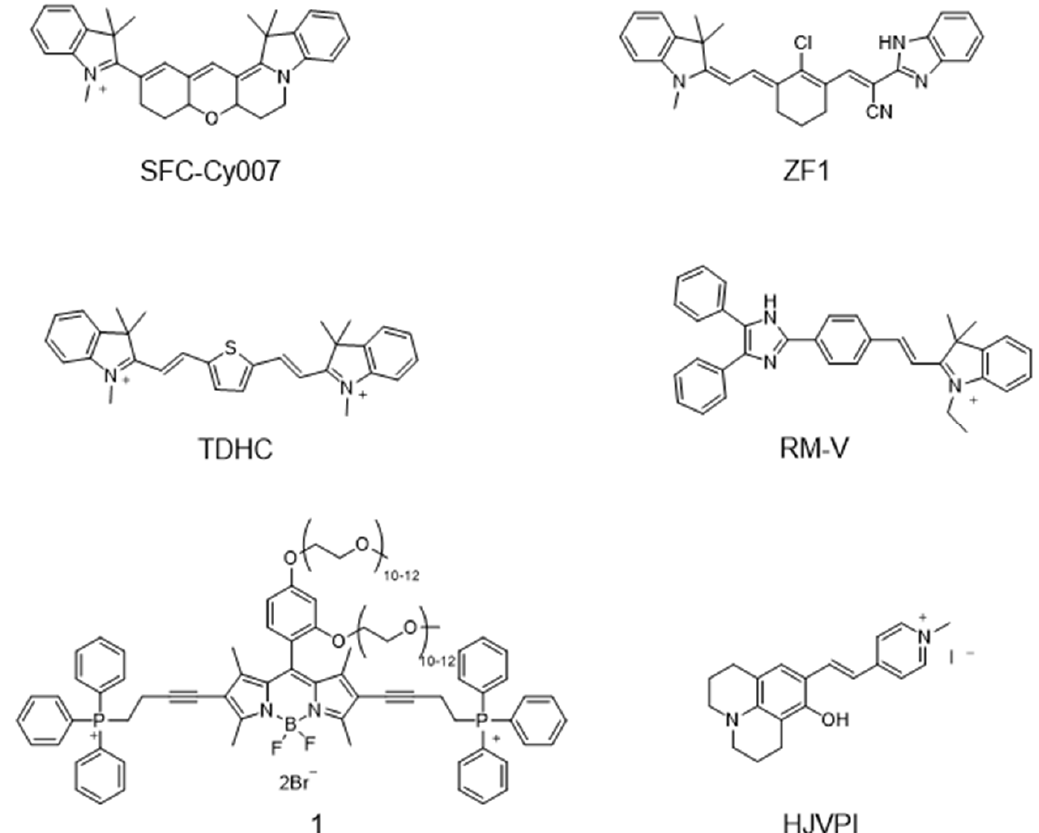
Figure 3. Typical fluorescent probes for visualizing mitochondrial viscosity.